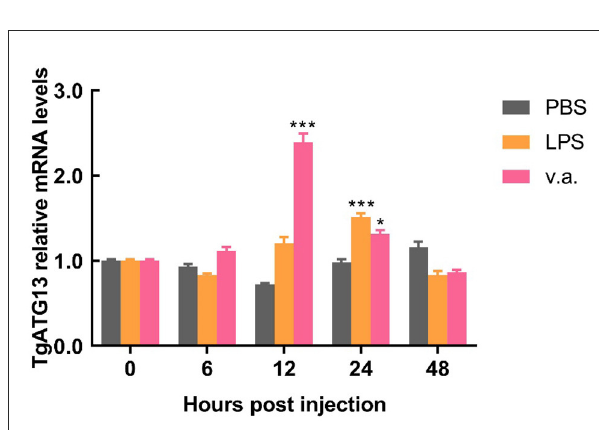
FIGURE7 Temporal expression pattern of the transcript of TgATG13 in blood clam hemocytes after challenges. The expression levels of TgATG13 mRNA in different time points post LPS and V. alginolyticus challenges were investigated using real time PCR assay with 18S rRNA as the internal control. Error bars represent the mean ± S.D. ( n = 3). * P < 0.05, *** P <